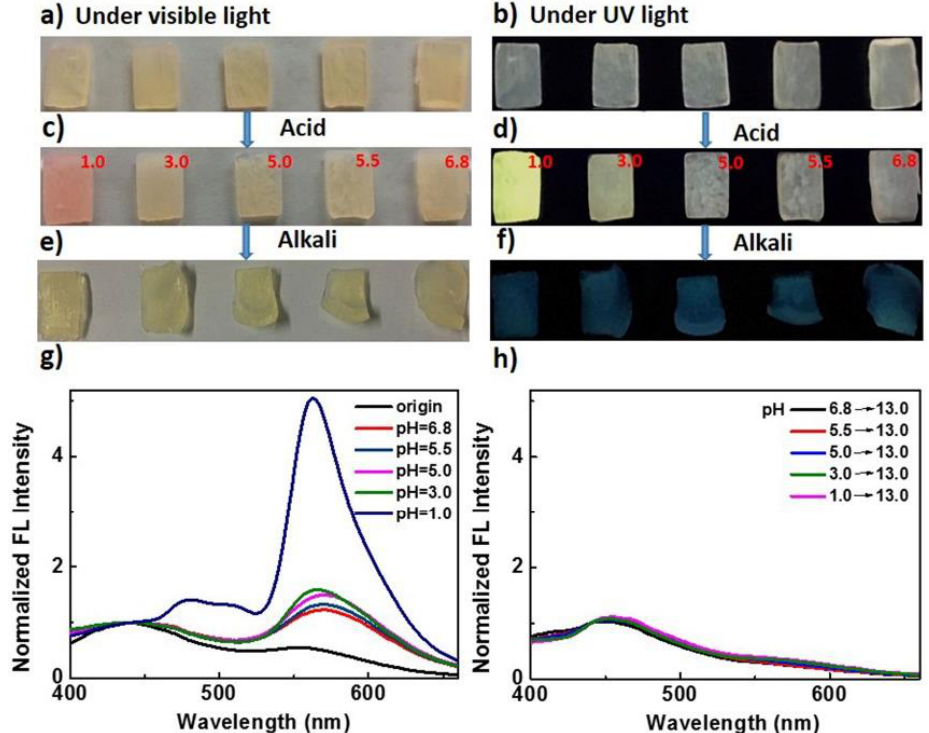
Figure 9. The optical ( a ) and fluorescent images ( b ) of the original poly(AAm-co-MA/Rh) hydrogels with a solid content of 70 wt%. The ( c ) optical and ( d ) fluorescent images of the hydrogels after swelling in water solutions with different pH (The pH values were noted in the images). The corresponding ( e ) optical and fluorescent ( f ) images of the hydrogels after further swelling in the alkaline solutions with a pH of 13.0. Emission spectra of the hydrogels ( g ) after swelling in water solutions with different pH values from 1.0 to 6.8 and ( h ) after further swelling in the alkaline solutions with a pH of 13.0.